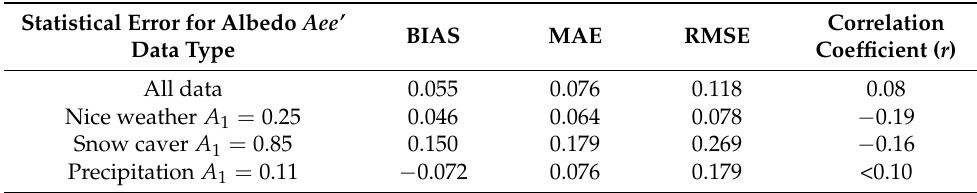
Table 6. Statistical errors: BIAS, MAE and RMSE based on the Nyren and Gryning [37] model of albedo for all data and separately for nice weather without snow cover ( A 1 = 0.25), for weather with snow cover and without precipitation ( A 1 = 0.85) and, finally, for precipitation weather ( A 1 = 0.11). Statistical Error for Albedo Aee’ Correlation BIAS MAE RMSE Data Type Coefficient ( r ) All data 0.055 0.076 0.118 0.08 Nice weather A 1 = 0.25 0.046 0.064 0.078 − 0.19 Snow caver A 1 = 0.85 0.150 0.179 0.269 − 0.16 Precipitation A 1 = 0.11 − 0.072 0.076 0.179